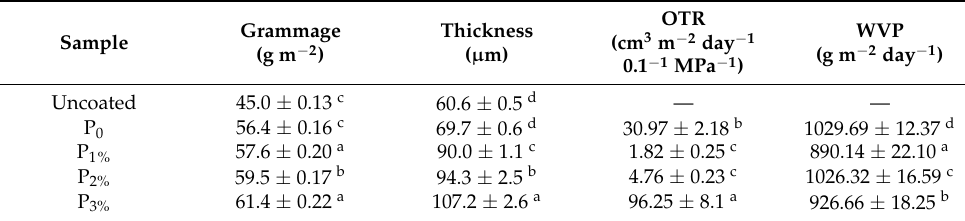
Figure 8. Scanning electron micrographs of ( a ) uncoated paper, ( b ) P 0 , ( c ) P 1% , ( d ) P 2% and ( e ) P 3% at 400× magnification. Table 1. Weight, thickness, OTR and WVP of uncoated and coated